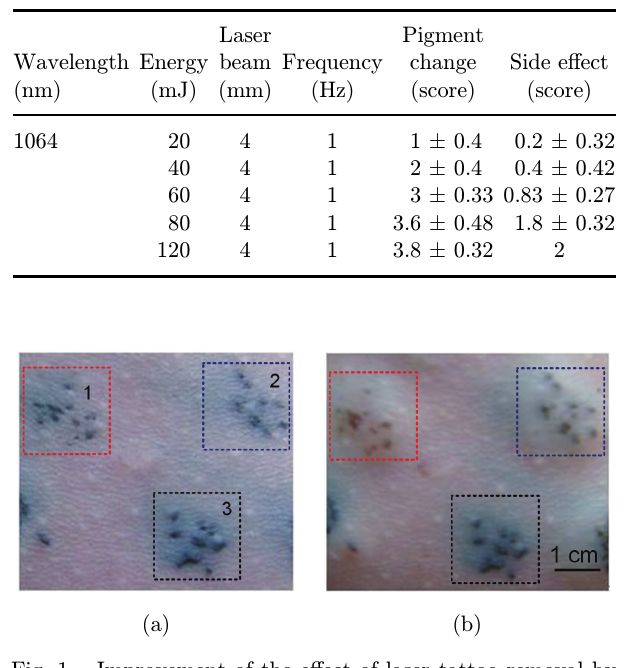
Fig. 1. Improvement of the e®ect of laser tattoo removal by skin OCA. (a) and (b) reveal the macroscopic pigmentation before and after treatment, respectively. Area 1: PT þ laser irradiation; area 2: laser irradiation; area 3: without treatment. Scale bar: 1 cm.